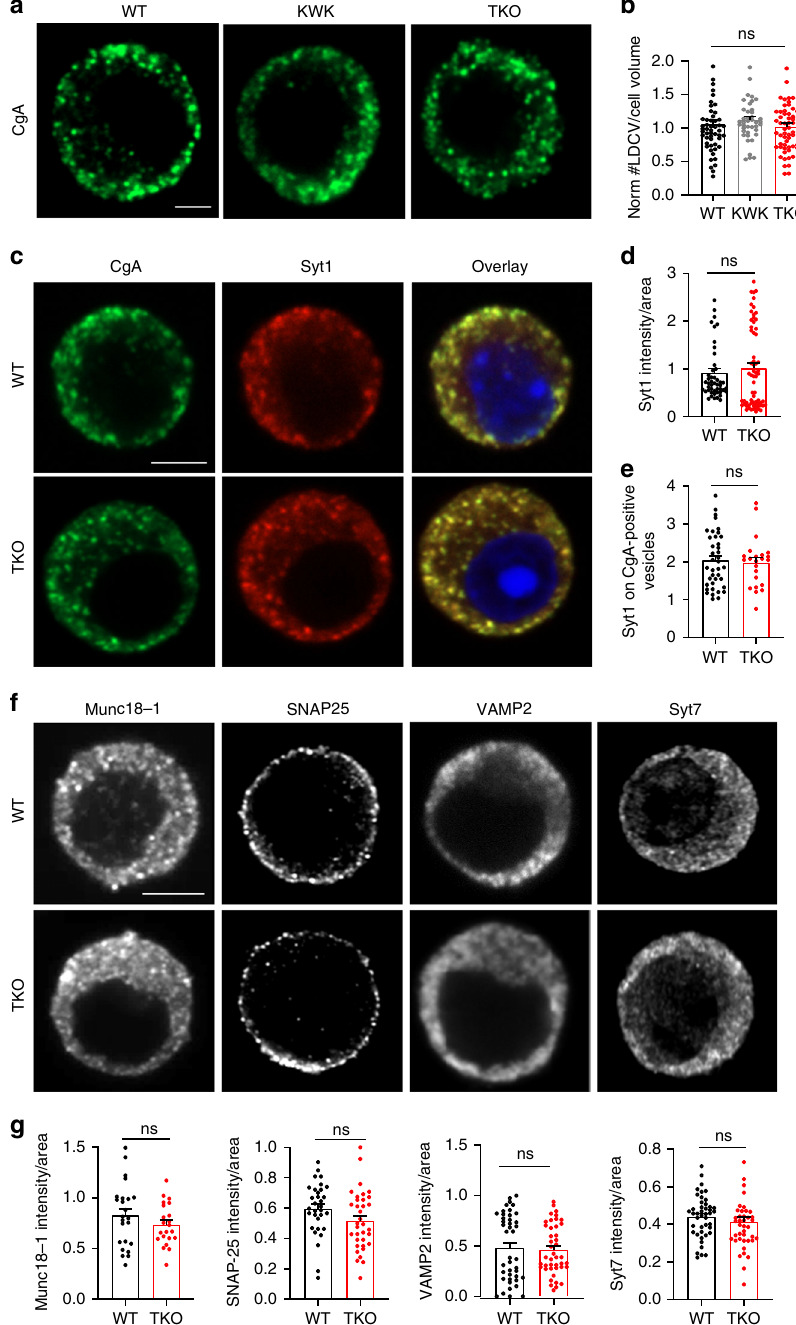
Fig. 4 Exocytic machinery is unaltered in the chromaf fi n cells without endophilin. a , b Confocal images of endophilin TKO and control (WT and littermate endophilin KOWTKO) chromaf fi n cells stained for chromogranin-A (CgA; LDCV marker) revealed no difference in the number of CgA-positive vesicles measured in the whole volume of the cell ( N = 4, WT 5 mice (54 cells), KOWTKO 4 mice (42 cells), and TKO 5 mice (57 cells), p -value = 0.96, one-way ANOVA with Tukey ’ s multiple comparison). An optical section through the equatorial plane of the cells is shown in a. Scale bar 3 µ m. c Images of endophilin TKO, littermate KOWTKO and WT chromaf fi n cells stained with anti-synaptotagmin-1 (Syt-1) and CgA antibodies. Scale bar 3 µ m. d Immuno fl uorescence levels revealed no change in synaptotagmin-1 levels ( N = 4, WT 5 mice (48 cells) and TKO 5 mice (67cells), p -value = 0.45, unpaired two-sided t -test). e Quanti fi cation of the Syt-1 intensity on the CgA-positive vesicles revealed no signi fi cant difference between the genotypes ( N = 4, WT 4 mice (39 cells) and TKO 3 mice (23 cells), p -value = 0.76, unpaired two-sided t -test). f Representative images of endophilin TKO and WT chromaf fi n cell stained for Munc18-1, SNARE proteins SNAP25 and VAMP2 and synaptotagmin-7. g Quanti fi cation of Munc18-1 ( N = 3, WT 3 mice (24 cells) and TKO 3 mice (22 cells), p -value = 0.25), SNAP-25 ( N = 3, WT 3 mice (32 cells) and TKO 3 mice (35 cells), p -value = 0.07), VAMP2 ( N = 3, WT 4 mice (43 cells) and TKO 4 mice (43 cells), p -value = 0.27) and Syt7 ( N = 3, WT 3 mice (44 cells) and TKO 3 mice (42 cells), p -value = 0.082) immuno fl uorescence showed no signi fi cant changes for any of these proteins. Error bars denote SEM. N = number of independent replicates. ns not signi fi